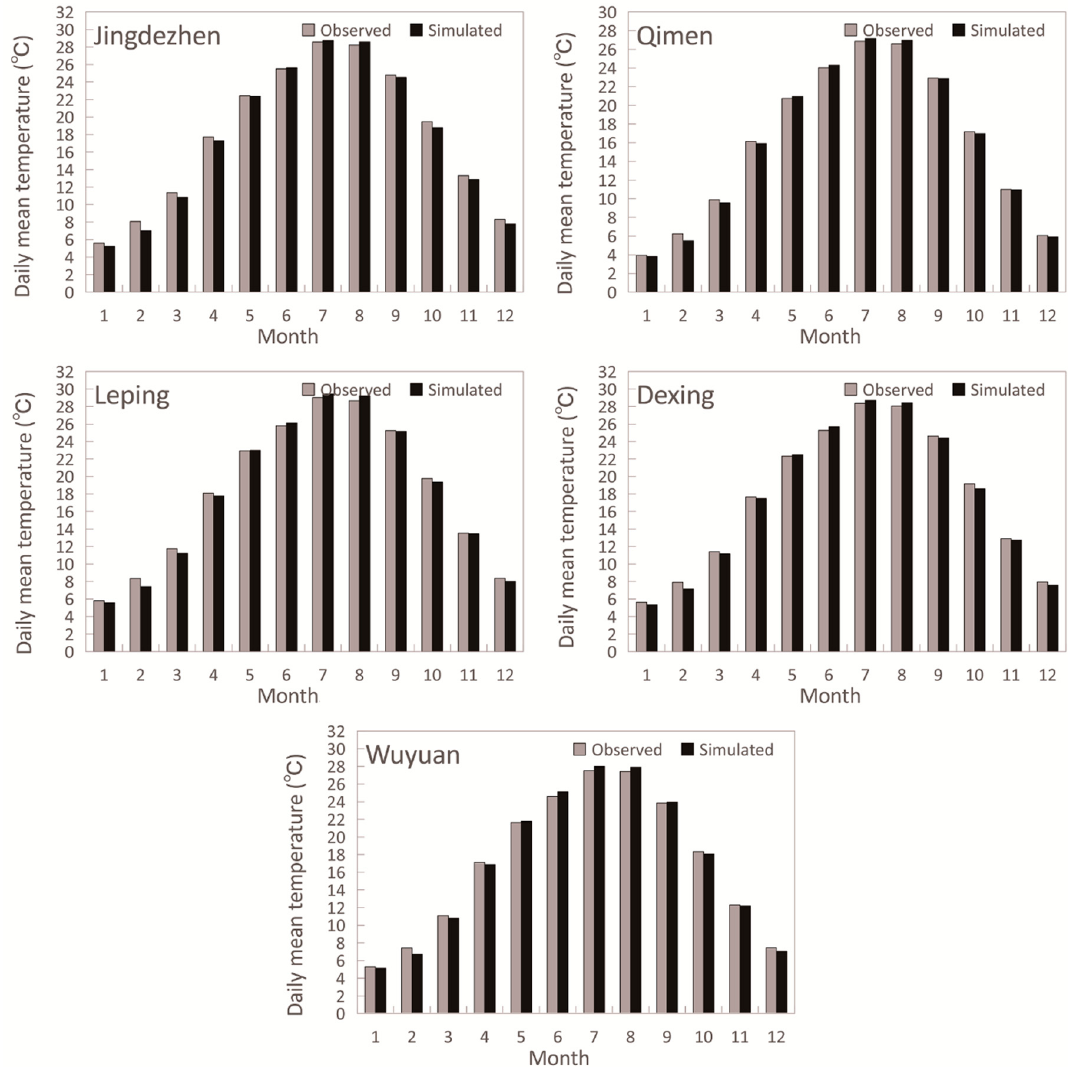
Figure 3. Observed and simulated daily mean temperature for the five meteorological stations in the validation period.